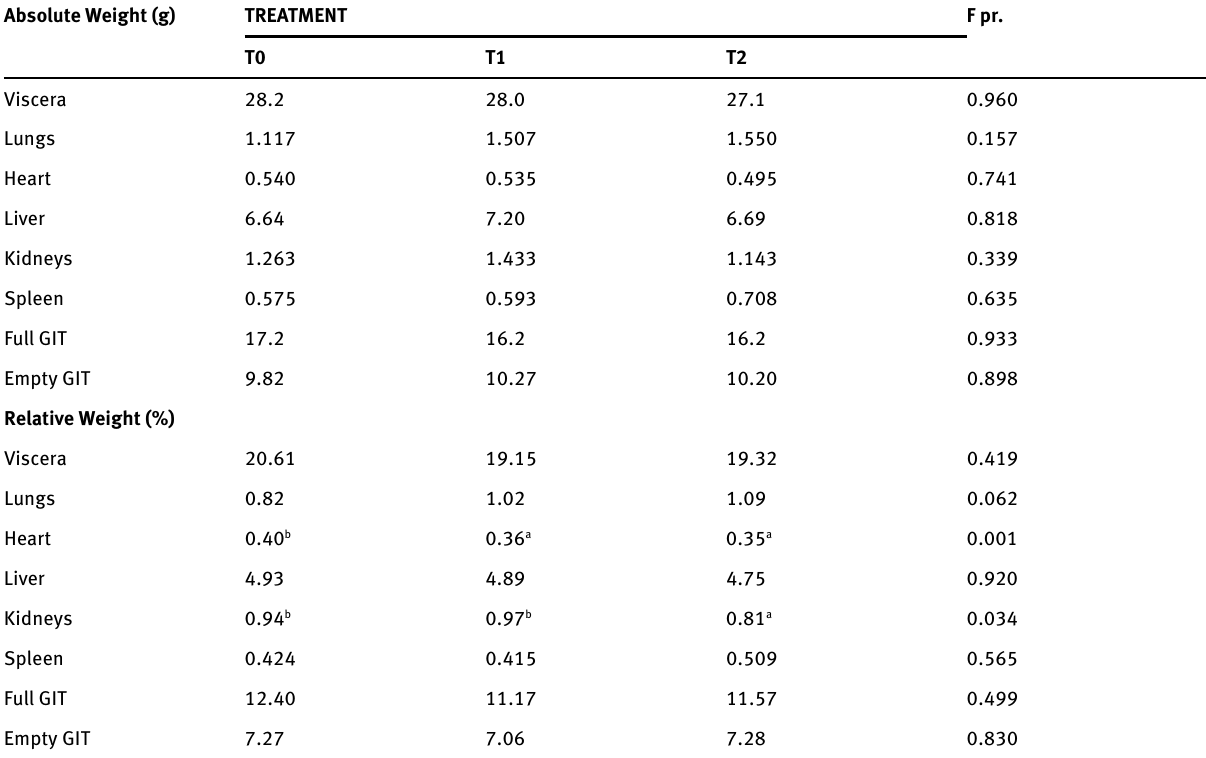
Table 4: Absolute and relative weights of internal organs of rats feed diets containing cockroach meal Absolute Weight